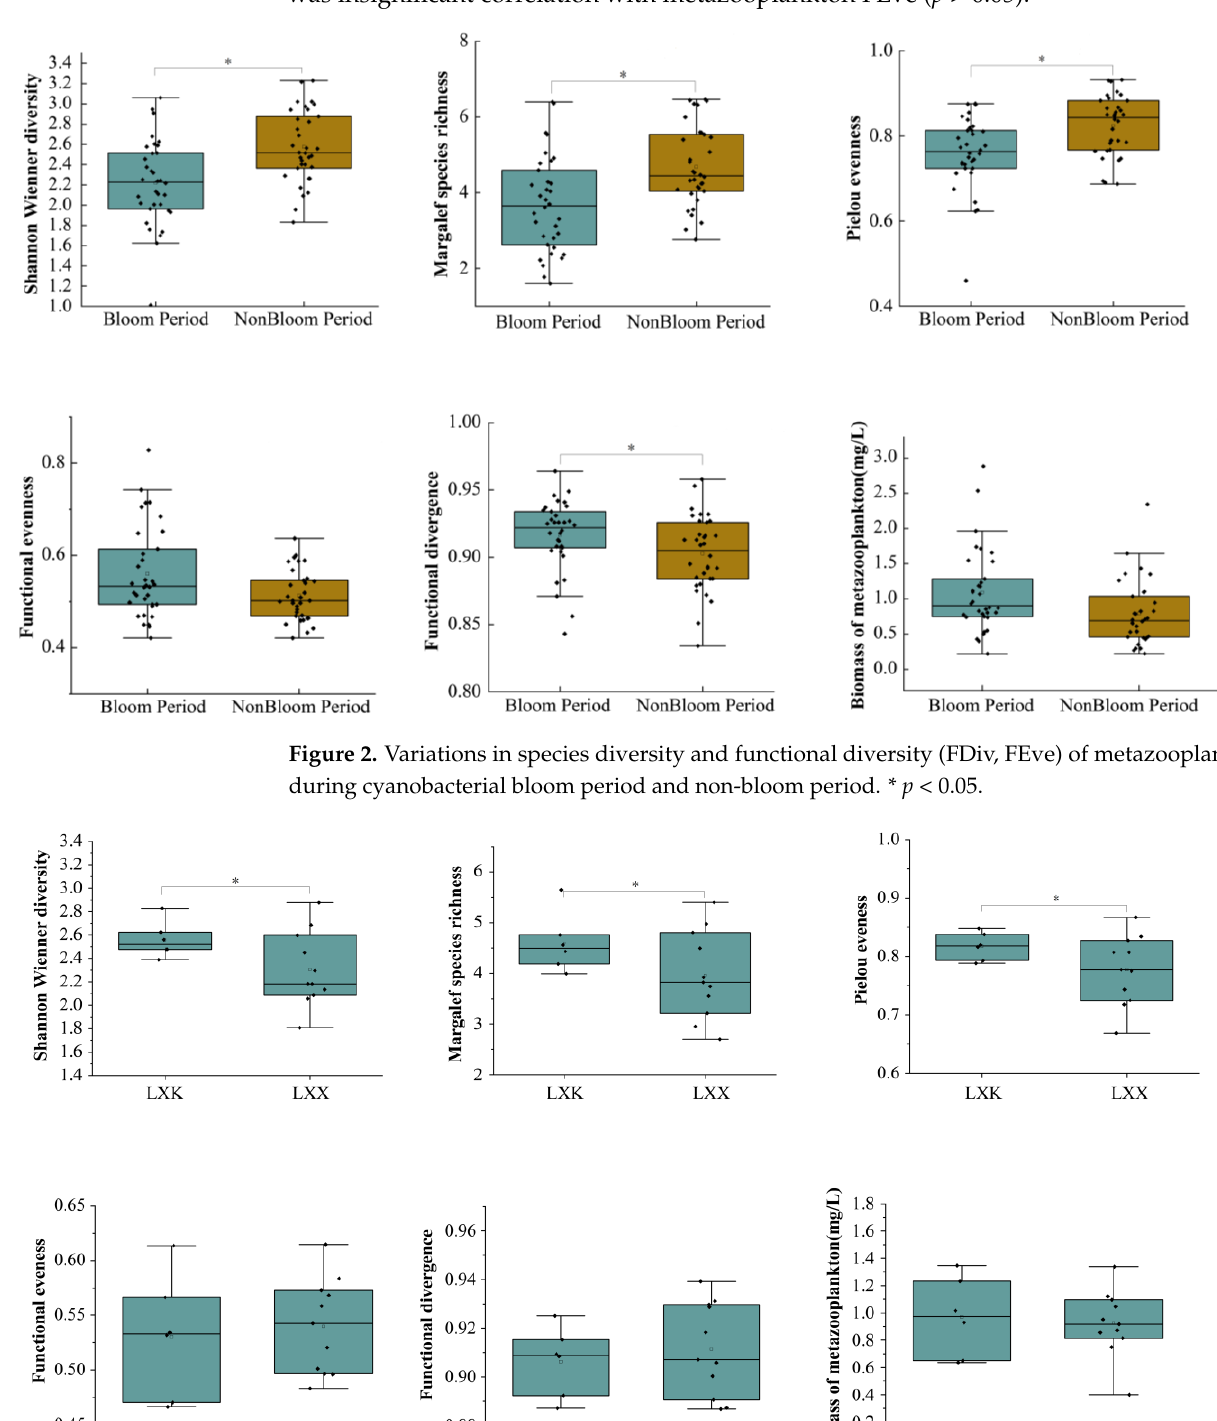
Figure 3. Variations in species diversity and functional diversity (FDiv, FEve) of metazooplankton in LXK and LXX. * p < 0.05.